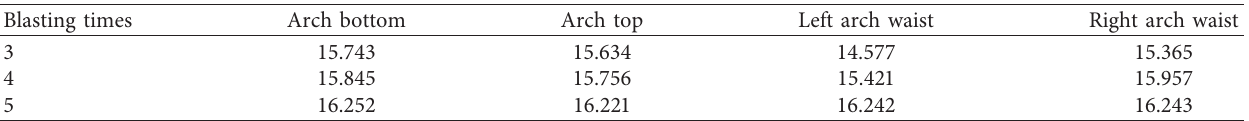
Table 10: The cumulative value of displacement at each measuring point of profile 1-1 when the thickness of the concrete spray layer is 350mm